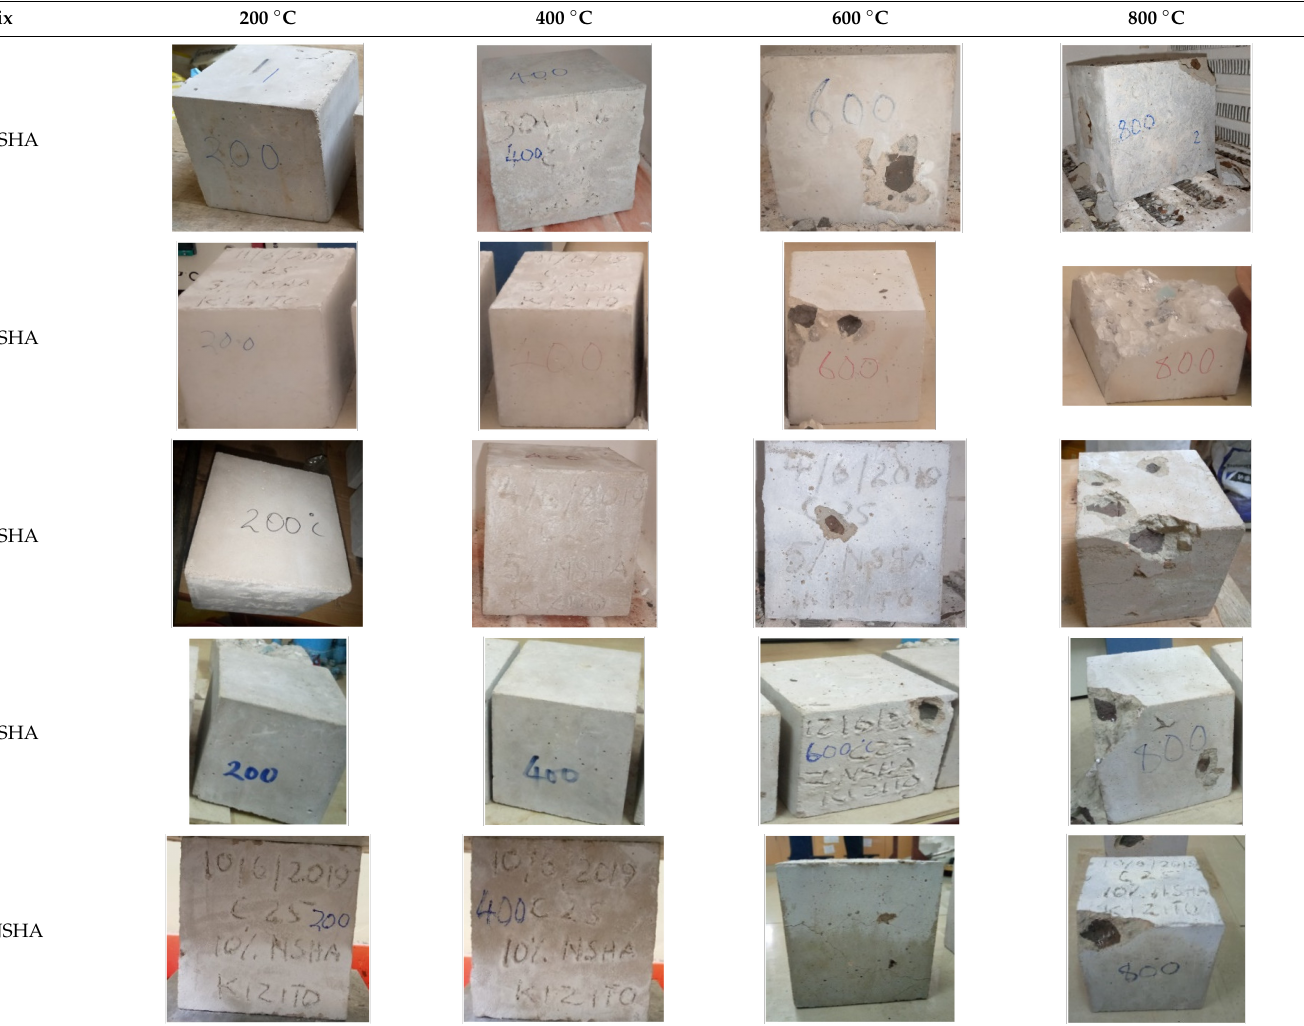
Table 4. Physical characteristics of concrete mixes at elevated